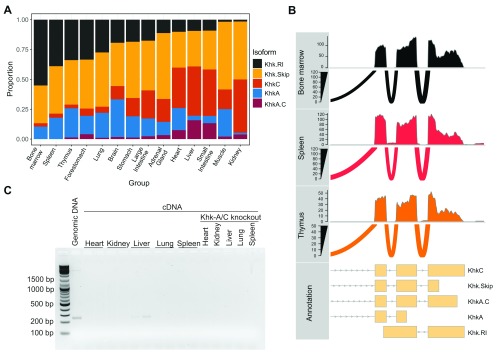

Khk.
RI expression levels are overestimated using Salmon quantifications.
A – Estimated relative
Khk isoform expression across all tissues in mouse. Proportions were output by DRIMseq using Salmon quantification as an input.
B – RNA-seq coverage tracks and sashimi plots highlighting the absence of
Khk.
RI expression in thymus, spleen and bone marrow samples. Data obtained from all biological replicates were merged prior to plotting.
C – Products derived from semiquantitative RT-PCR analysis on cDNAs prepared from total RNA of different mouse organs using the primers specific for
Khk.RI. Genomic DNA isolated from the liver was used as positive and RNA isolated from organs of
Khk-A/C knockout mice as negative control. (n = 5 and products from two representative mice are shown).